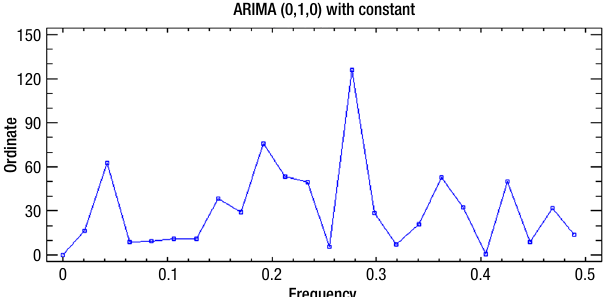
Fig. 15b. Residual periodogram for adjusted time series of annual Argentinian GDP